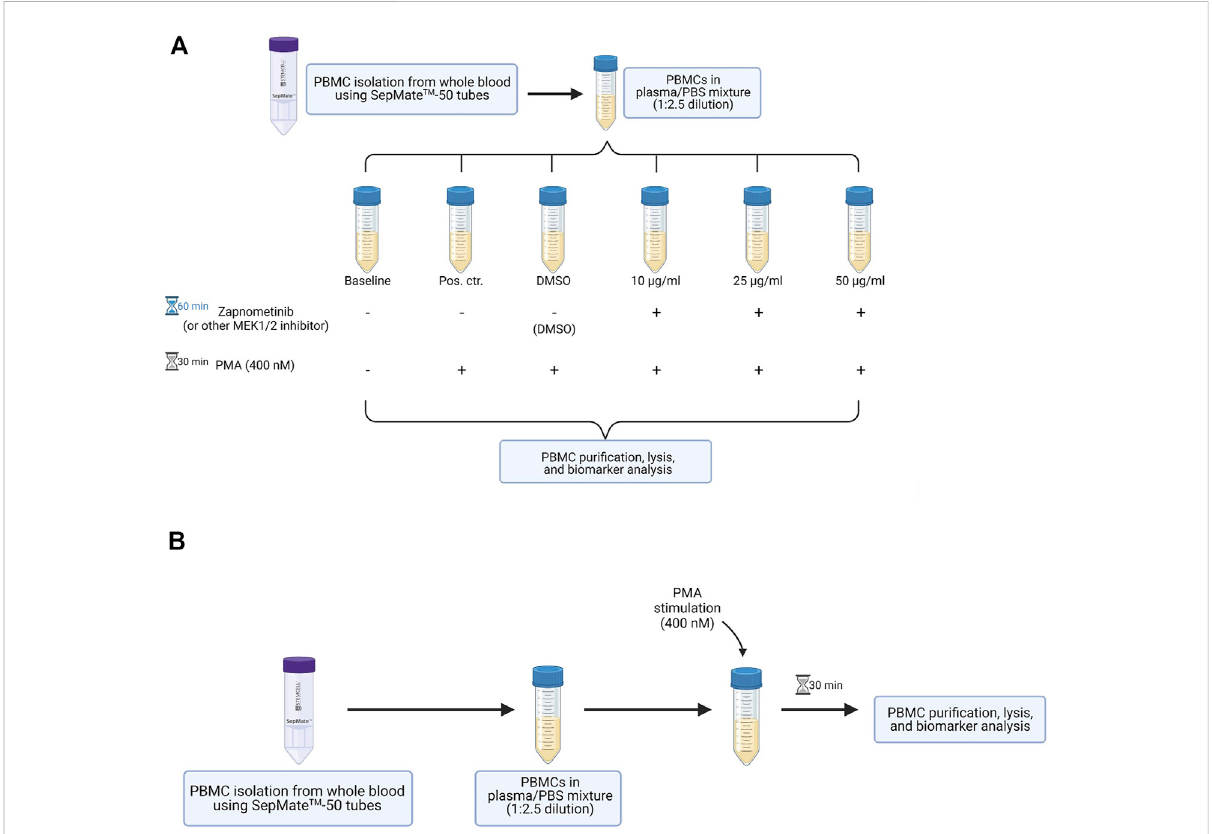
FIGURE 1 Overview of the method developed to assess MEK1/2 inhibition in PBMCs of healthy probands. (A) Work fl ow for the in vitro proof of principle experiment. PBMCs are isolated from whole blood and are maintained in the plasma obtained during PBMC isolation. The cells are treated with differentconcentrationsofaMEK1/2inhibitorfor 60 min,followed by30 minstimulationwith 400 nMPMA.PBMCsarepuri fi ed,lysed,andanalyzed for their ERK1/2 phosphorylation status. (B) Work fl ow for the in vitro stimulation of PBMCs isolated from MEK1/2 inhibitor-treated subjects. PBMCs are isolated from whole blood and maintained in the plasma obtained during isolation. The cells are stimulated 30 min with 400 nM PMA, followed by puri fi cation, lysis, and analysis for their ERK1/2 phosphorylation status. This fi gure was created with